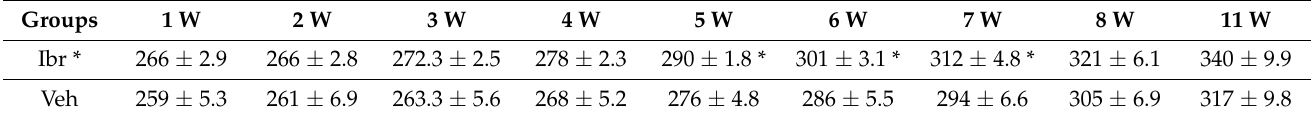
Table 2. Body Weight of Animals Per Week (G). Values are Mean ± SEM. At 1, 2, 3, 4 and 11 weeks, there are no significant differences in the bodyweight of animals per week were found between the vehicle- and Ibrutinib-treated animals ( n = 10 per group); At 5, 6, and 7 weeks Ibrutinib treatment increased body weight of animals per week compared to vehicle-treated group. * Ibr: SCI + Ibrutinib treatment; Veh: SCI + Vehicle treatment.